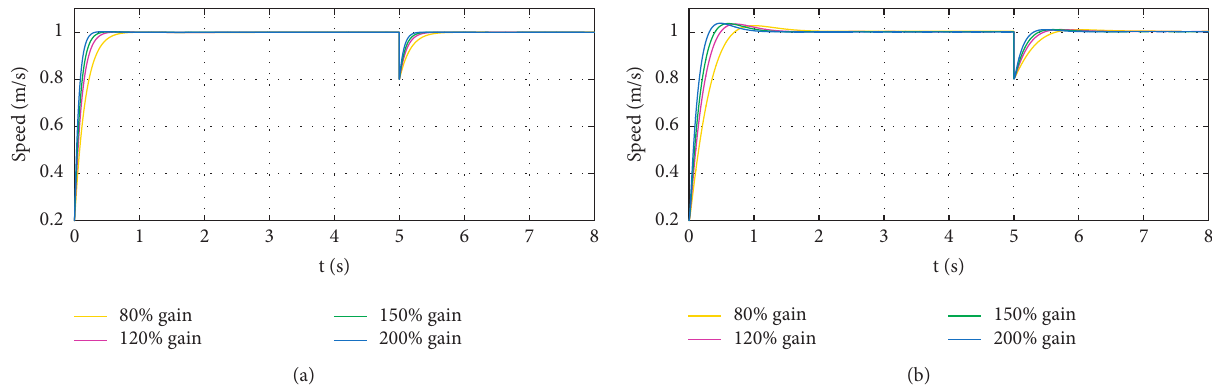
Figure 8: Speed regulation comparison with disturbance and gain variations: (a) FOPID and (b) PID.